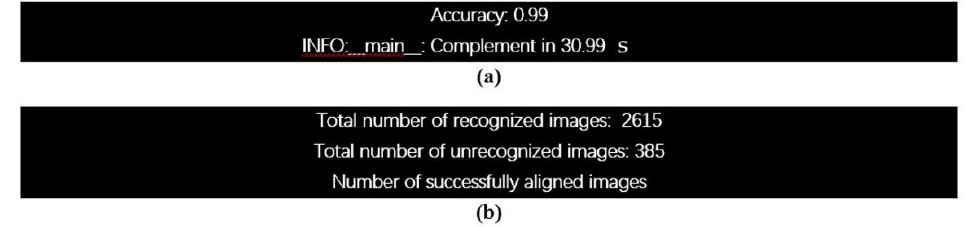
Figure 10. Evaluation test of the face classifiers on the DHU Night dataset for face recognition with gender classification: ( a ) accuracy rate, and ( b ) the result of the total number of recognized, unrecognized, and aligned images.